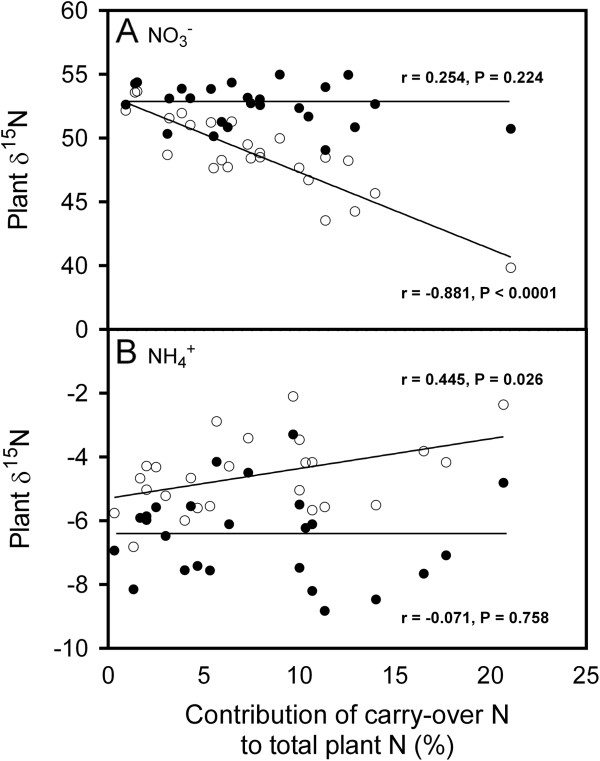
Unadjusted (open symbols) and adjusted (closed symbols) δ15N for new growth of the whole plant plotted against the per cent contribution of carry-over nitrogen to new growth of Populus balsamifera L. supplied with either nitrate (A) or ammonium (B). Each data point represents a genotypic mean (N = 3). Correlation coefficients and P-values are placed near each line.